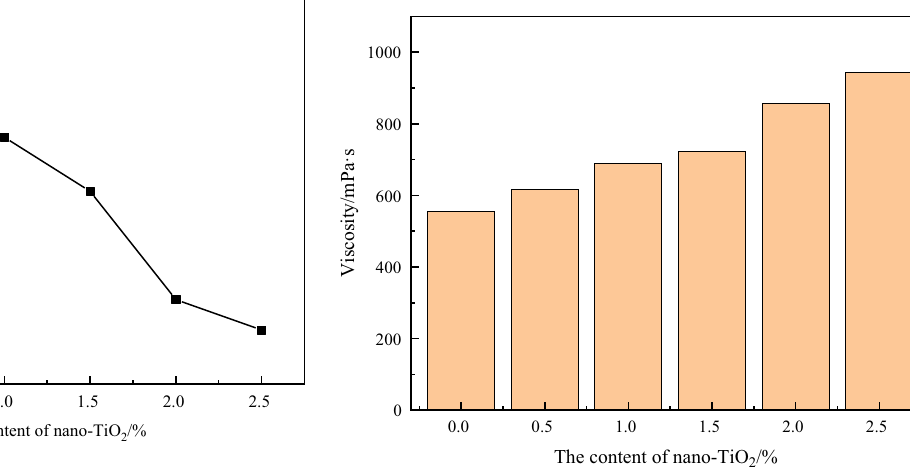
Figure 9: E ff ect of di ff erent content of TiO 2 particles on curing shrinkage of resin. Figure 10: E ff ect of TiO 2 content on the viscosity of